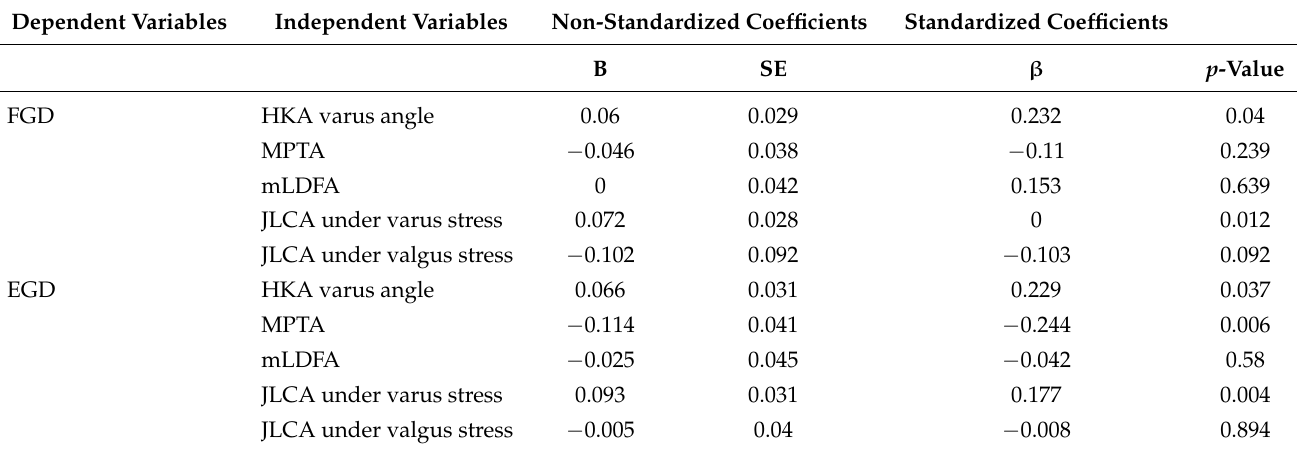
Table 5. Multiple regression analysis of factors that affect gap